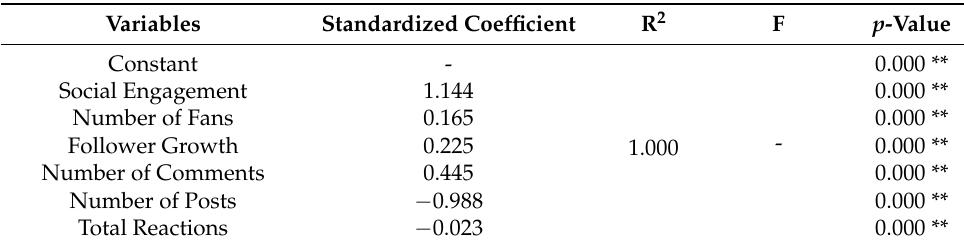
Table 7. Impact of social media analytics on CPNs websites’ social traffic.